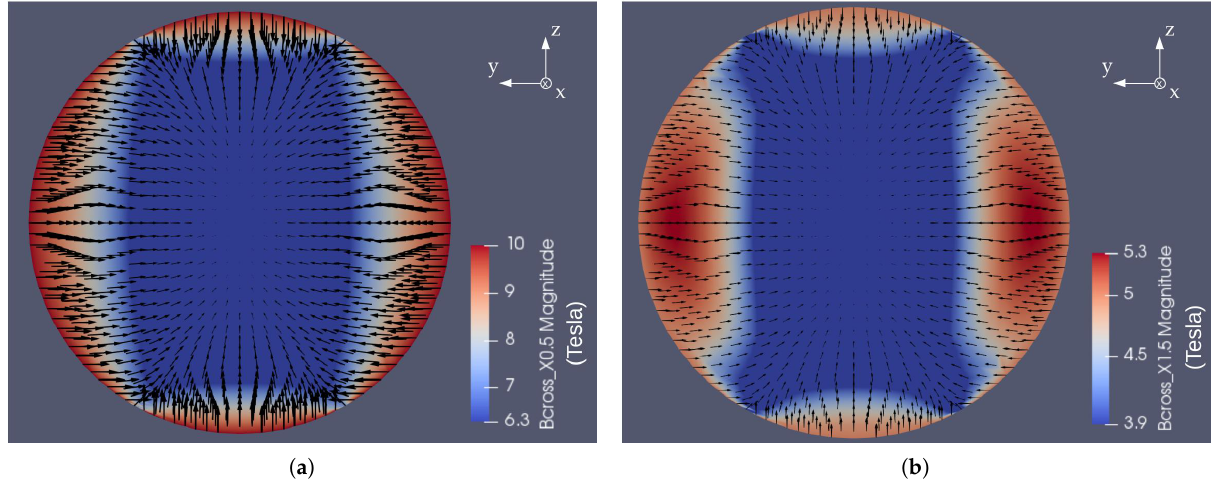
Figure 5. Distribution of magnetic induction in the duct cross-section at ( a ) x = 0.5 m and ( b ) x = 1.5 m. Magnets are in the repulsive configuration.